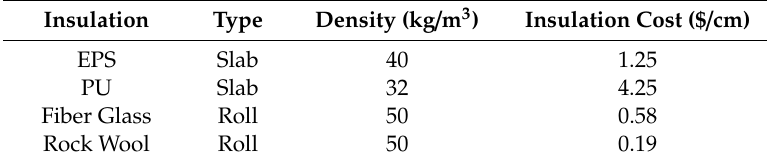
Table 1. Insulation costs to cover an area of 1 m 2 of roof.